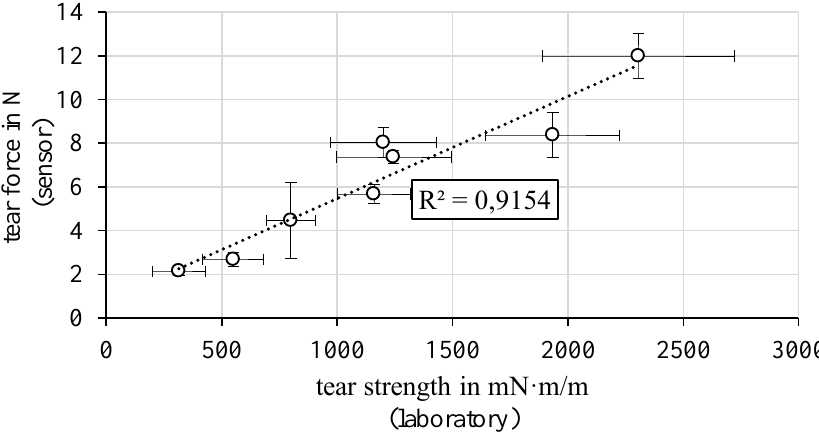
Figure 7. Correlation between the tear work measured in the laboratory and the tear force measured by the